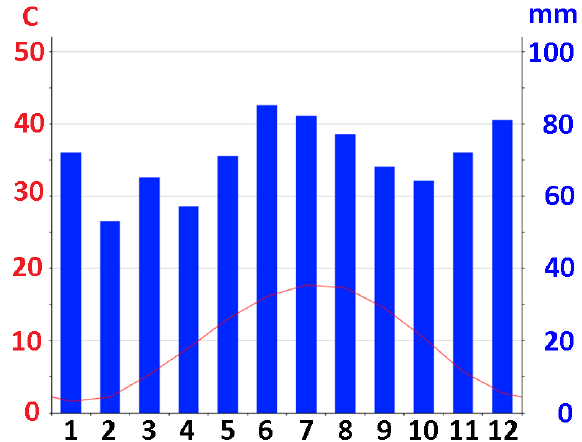
Figure 9. Average yearly temperature (red) and rainfall (blue) (Hattingen, Germany, 1982 - 2012) from CLIMATE- DATA.ORG